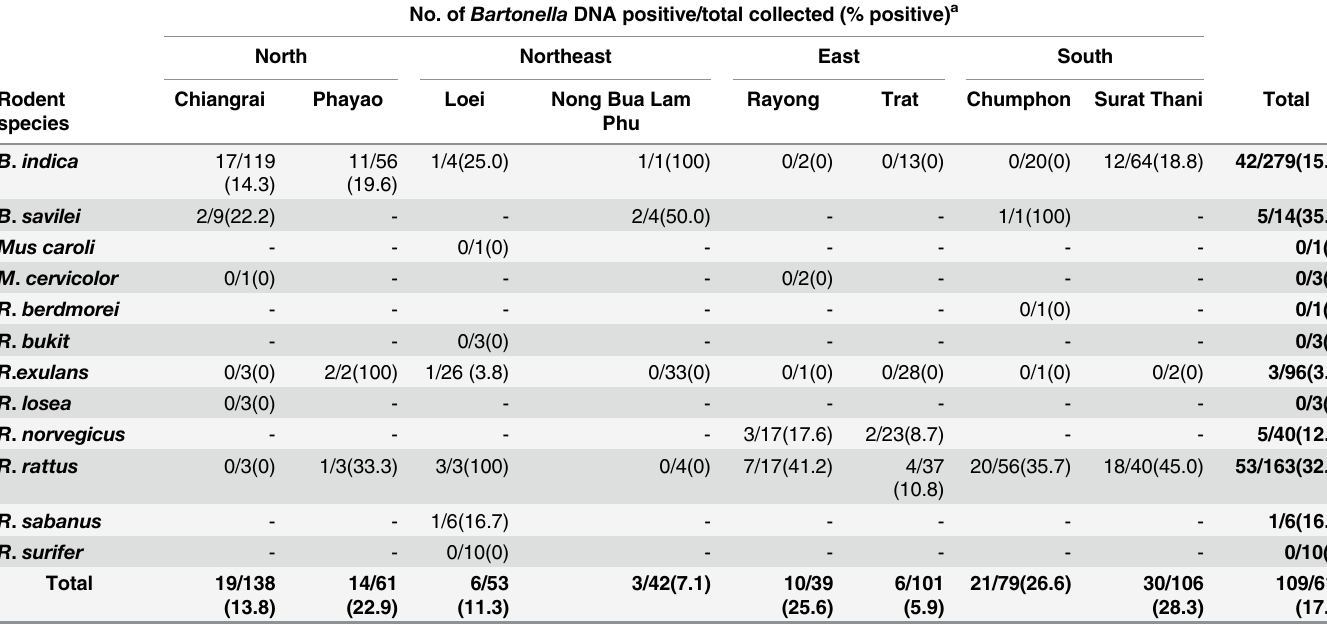
Table 3. Distribution of Bartonella DNA among rodent species in different regions and provinces of Thailand, 2012 – 2013. No. of Bartonella DNA positive/total collected (% positive)